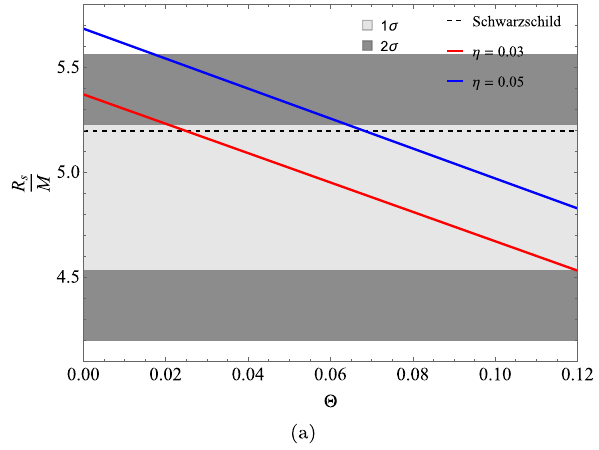
Fig. 11 The shadow radius as a function of (cid:11) , crossing regions of 1 σ ( 4 . 54 (cid:2) R s / M (cid:2) 5 . 22 ) (lightgrey)and2 σ ( 4 . 20 (cid:2) R s / M (cid:2) 5 . 56 ) (dark grey) for η = 0 . 03 , 0 .